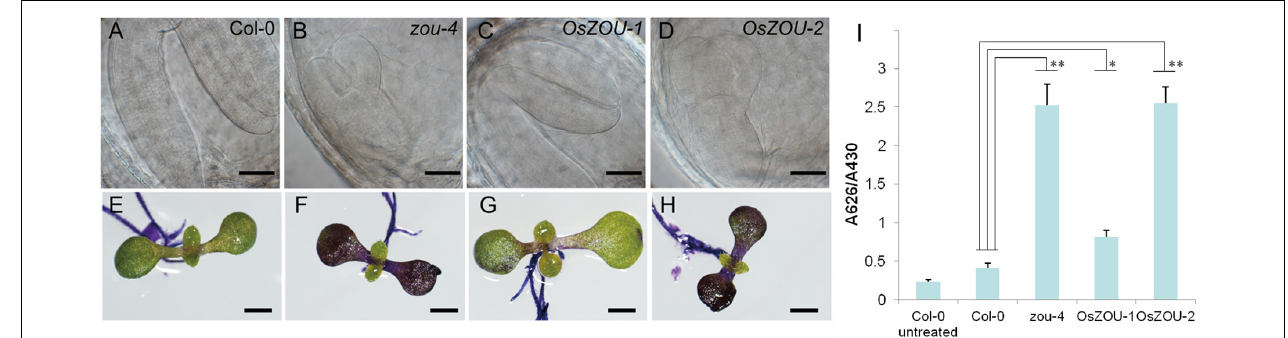
FIGURE 4 | Seed development and embryonic cuticle integrity. Phenotype analyses of the independent transgenic events OsZOU-1#1 , #4 , and #5 and OsZOU-2#1 , #3 , and #5 were performed, but only images from OsZOU-1#4 and OsZOU-2#3 , considered representative of all other events, are presented here. (A–D) The embryo of Col-0, Atzou-4 , OsZOU-1 transgenic, and OsZOU- 2 transgenic plants at ten DAP were observed under Differential Interference Contrast (DIC) microscopy. Scale bars = 0.1 mm. The embryo of Col-0 plant was bent, almost occupying the entire seed cavity with only one cell layer of endosperm surrounding the embryo (A) . The Atzou-4 mutant embryo was arrested in the heart/torpedo stage and its endosperm remained intact (B) . In OsZOU-1 transgenic seeds, the bent embryo occupied most of the seed cavity, and the endosperm showed breakdown (C) . The embryo and endosperm of OsZOU-2 transgenic seeds were the same as those of the Atzou-4 mutant (D) . Scale bars in (A–D) are 50 µ m. (E–I) OsZOU-1 partially recovered the cuticle deficiency in Atzou-4 . Scale bars in (E–I) are 1 mm. Seedlings of the Col-0 (E) , Atzou-4 (F) , OsZOU-1 (G) , and OsZOU-2 (H) transgenic lines on the seventh day after germination were stained with TB. Results show that OsZOU-1 transgenic seedlings were weakly stained (G) , while those of the OsZOU-2 seedlings showed strong staining similar to that in the Atzou-4 mutants (H) . TB uptake in these lines was quantified spectrophotometrically and revealed similar results to microscopy analysis. The mean values of OsZOU-1#1 , #4 , and #5 represent the results for OsZOU-1 transgenic lines, while the mean values of OsZOU-2#1 , #3 , and #5 represent the results for OsZOU-2 transgenic lines. Error bars denote the SDs of three biological replicates, each containing 20 seedlings (I) . Student’s t -test value: ∗ p < 0.05, ∗∗ p <